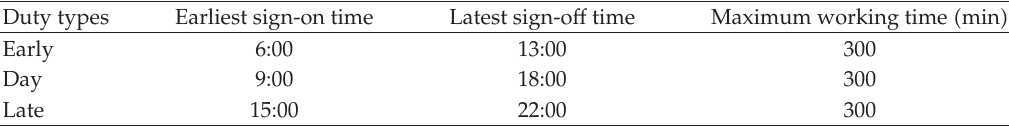
Table 2: Parameter of di ff erent duty types.